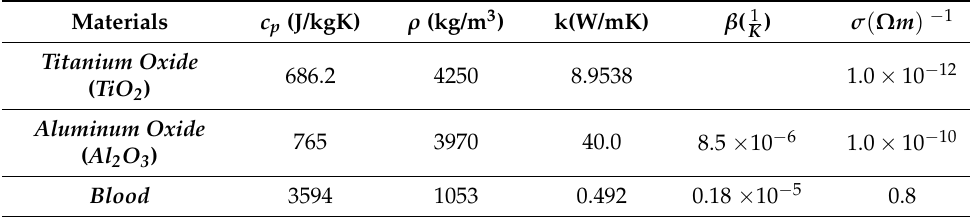
Table 2 represents thermophysical properties of nanoparticles and base fluids. Table 2. Thermophysical values of nanoparticles and base fluid [29].